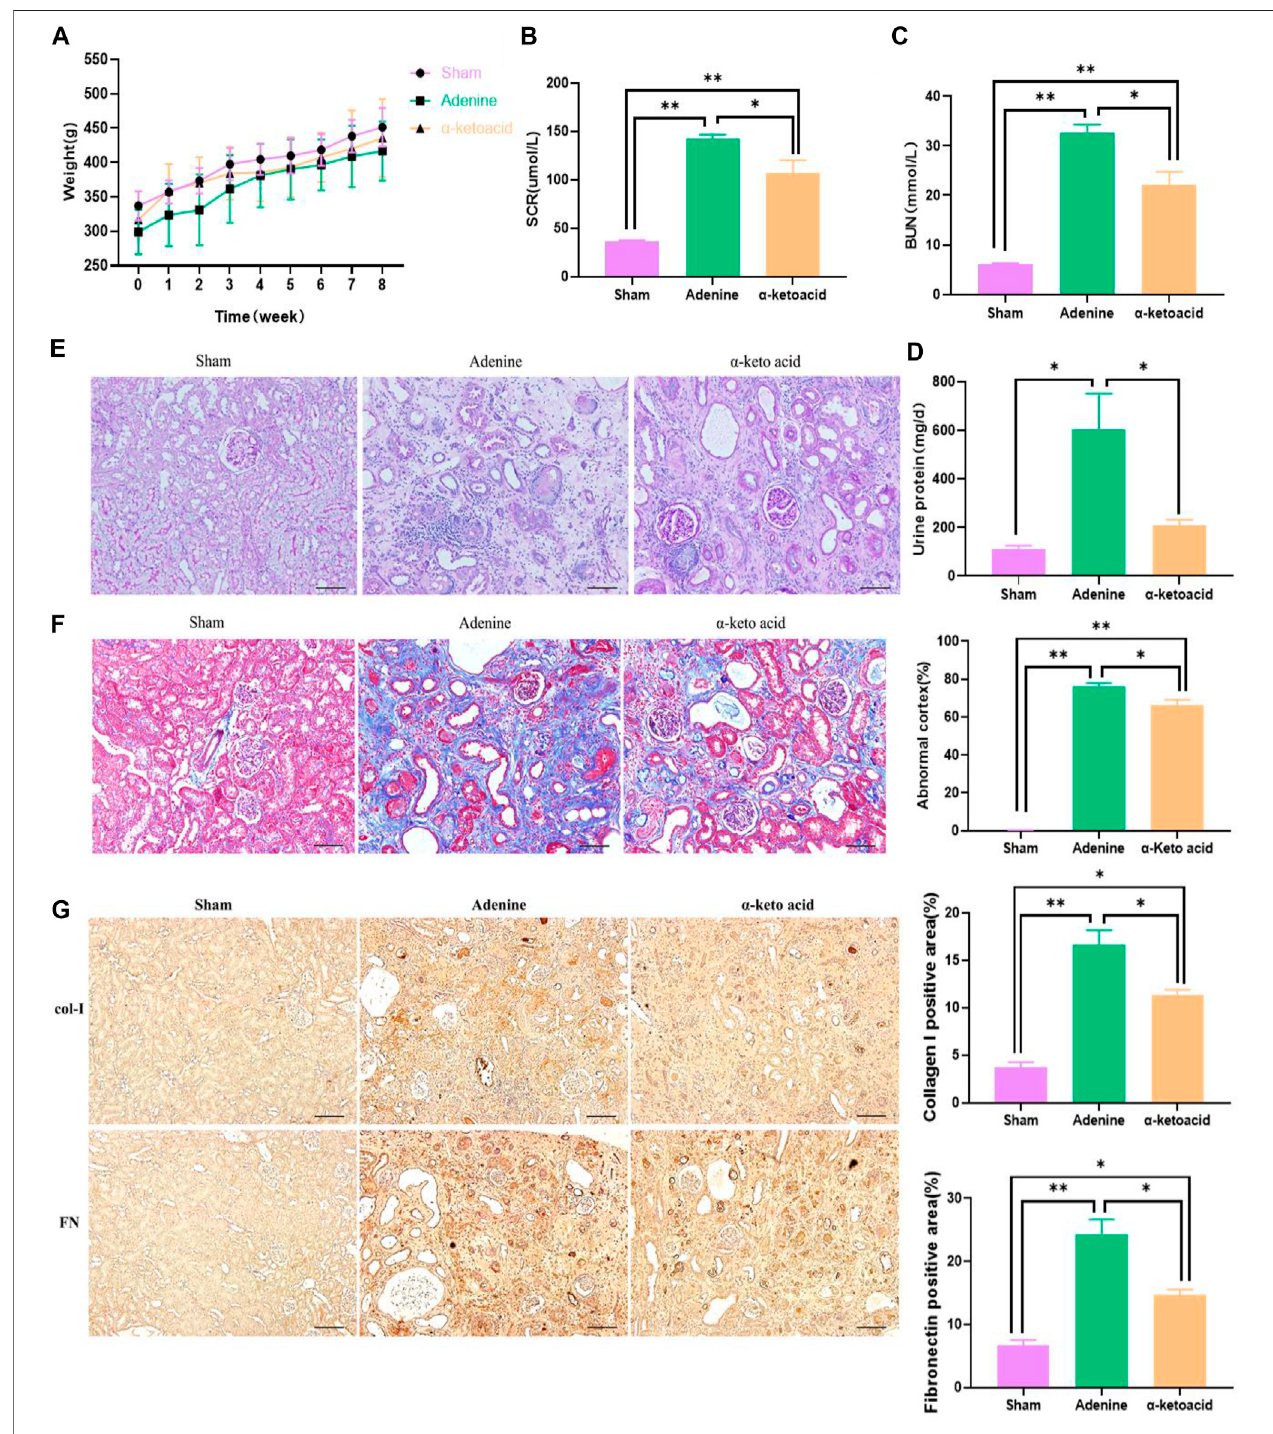
FIGURE 1 | α -Ketoacid alleviated renal failure phenotypes in adenine-induced CKD rats. (A) Body weight. (B) Serum creatinine. (C) Blood urea nitrogen. (D) Twenty-four-hoururinaryproteinquantitation. (E) PASstainingofkidneytissue. (F) Massonstainingofkidneytissue. (G) ImmunohistochemicalstainingofCollagenIand Fibronectin expression. Data are presented as the means ± standard error of the mean, n (cid:1) 8 rats per group (* p < 0.05, ** p < 0.001).